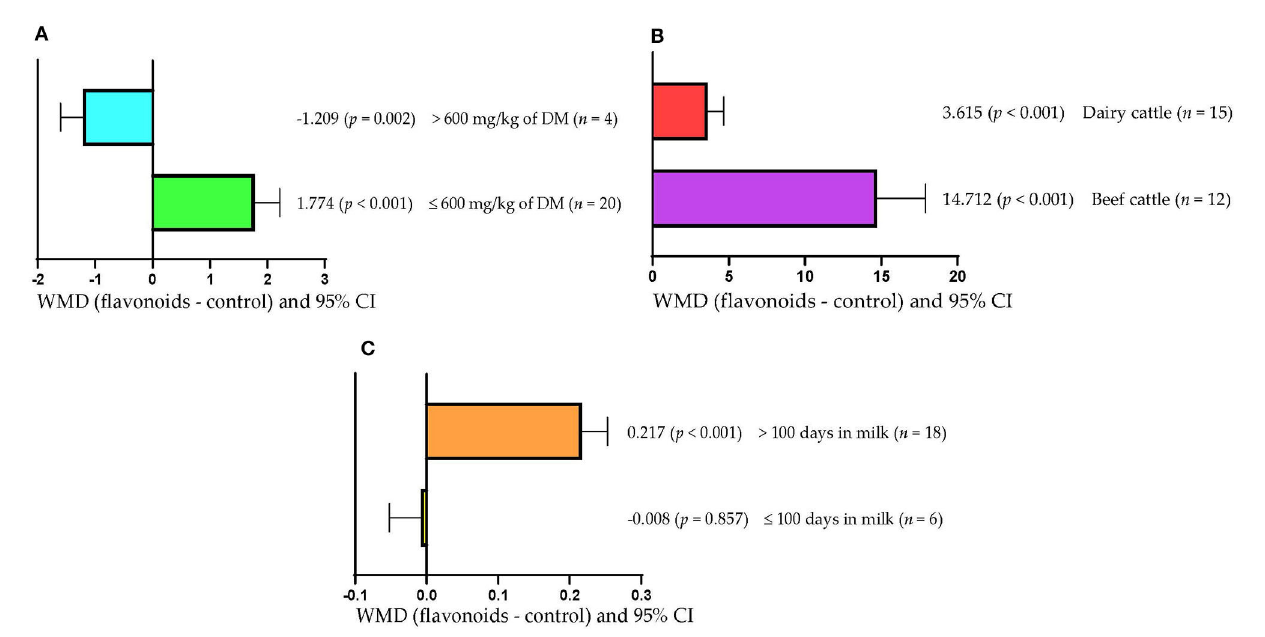
FIGURE6 Subgroup analysis [subgroup flavonoid dose (mg/kg of DM), type of cattle (beef cattle or dairy cattle), and days in milk] of the effect of flavonoids on the = diet of the cattle; WMDs, weighted mean differences between flavonoid treatments and control. (A) Milk production, kg/d. (B) Superoxide dismutase (SOD), U/mL. (C) Mil fat,